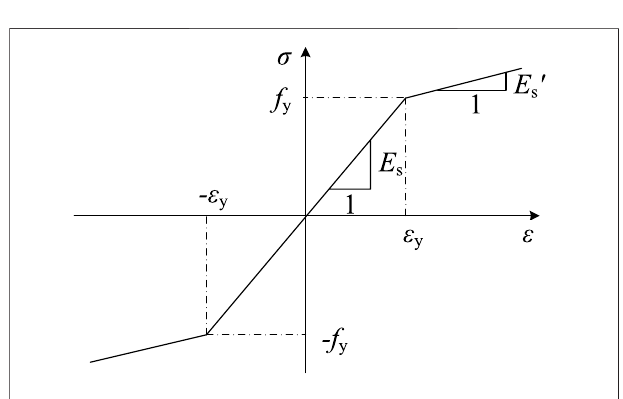
FIGURE 5 | Stress-strain constitutive relation of the